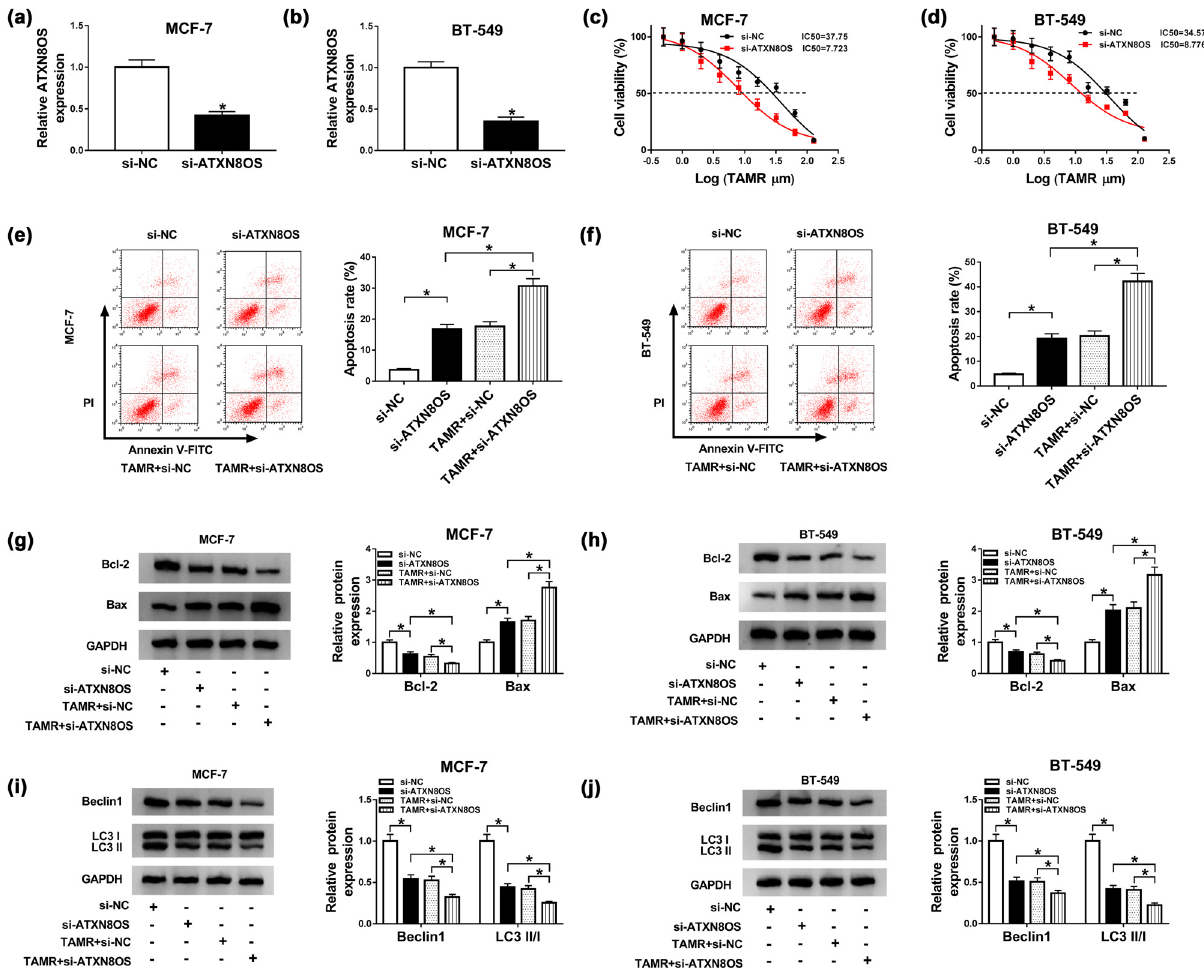
Figure 2: ATXN8OS depletion enhanced TAMR sensitivity in BC cells. ( a and b ) MCF - 7 and BT - 549 cells were transfected with si - NC or si - ATXN8OS, followed by the determination of ATXN8OS expression by qRT - PCR 48 h post - transfection. ( c and d ) MCF - 7 and BT - 549 cells were transfected with si - NC or si - ATXN8OS and then were exposed to various concentrations ( 0.5, 1, 2, 4, 8, 16, 32, 64, and 128 µm ) of TAMR for 48 h, followed by the measurement of cell viability using MTT assay. MCF - 7 and BT - 549 cells were transfected with si - NC or si - ATXN8OS and then were treated with 10 µm of TAMR for 48 h, followed by the determination of cell apoptosis by fl ow cytometry ( e and f ) , Bcl - 2 and Bax levels by western blot ( g and h ) , and the levels of Beclin 1, LC3 I, and LC3 II by western blot ( i and j ) . * P <